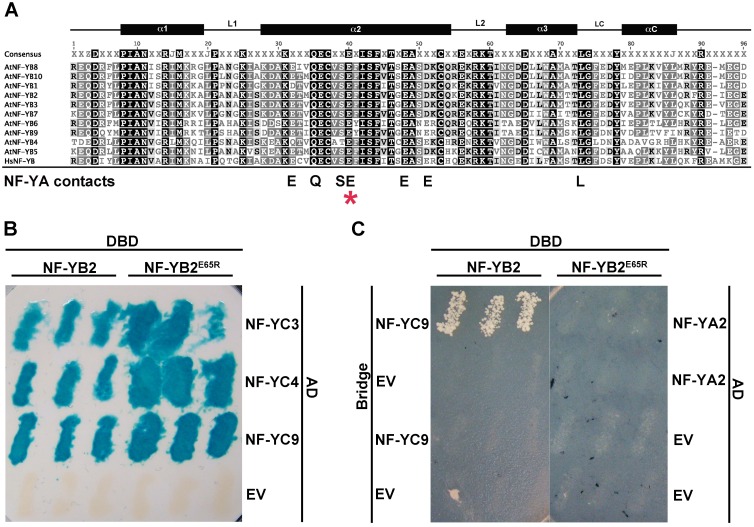
NF-YB2E65R loses interaction with NF-YA subunits.A) Alignment of the core domain of human and Arabidopsis NF-YB subunits. * marks the position of the conserved glutamic acid required for interaction with NF-YA in humans [27]. B) NF-YB2 and NF-YB2E65R interact with NF-YC3, NF-YC4, and NF-YC9 in Y2H assays. C) NF-YB2, but not NF-YB2E65R, interacts with NF-YA2 when NF-YC9 is expressed using a bridge vector in yeast three-hybrid assays. DBD: DNA binding domain, AD: activation domain, EV: empty vector control.